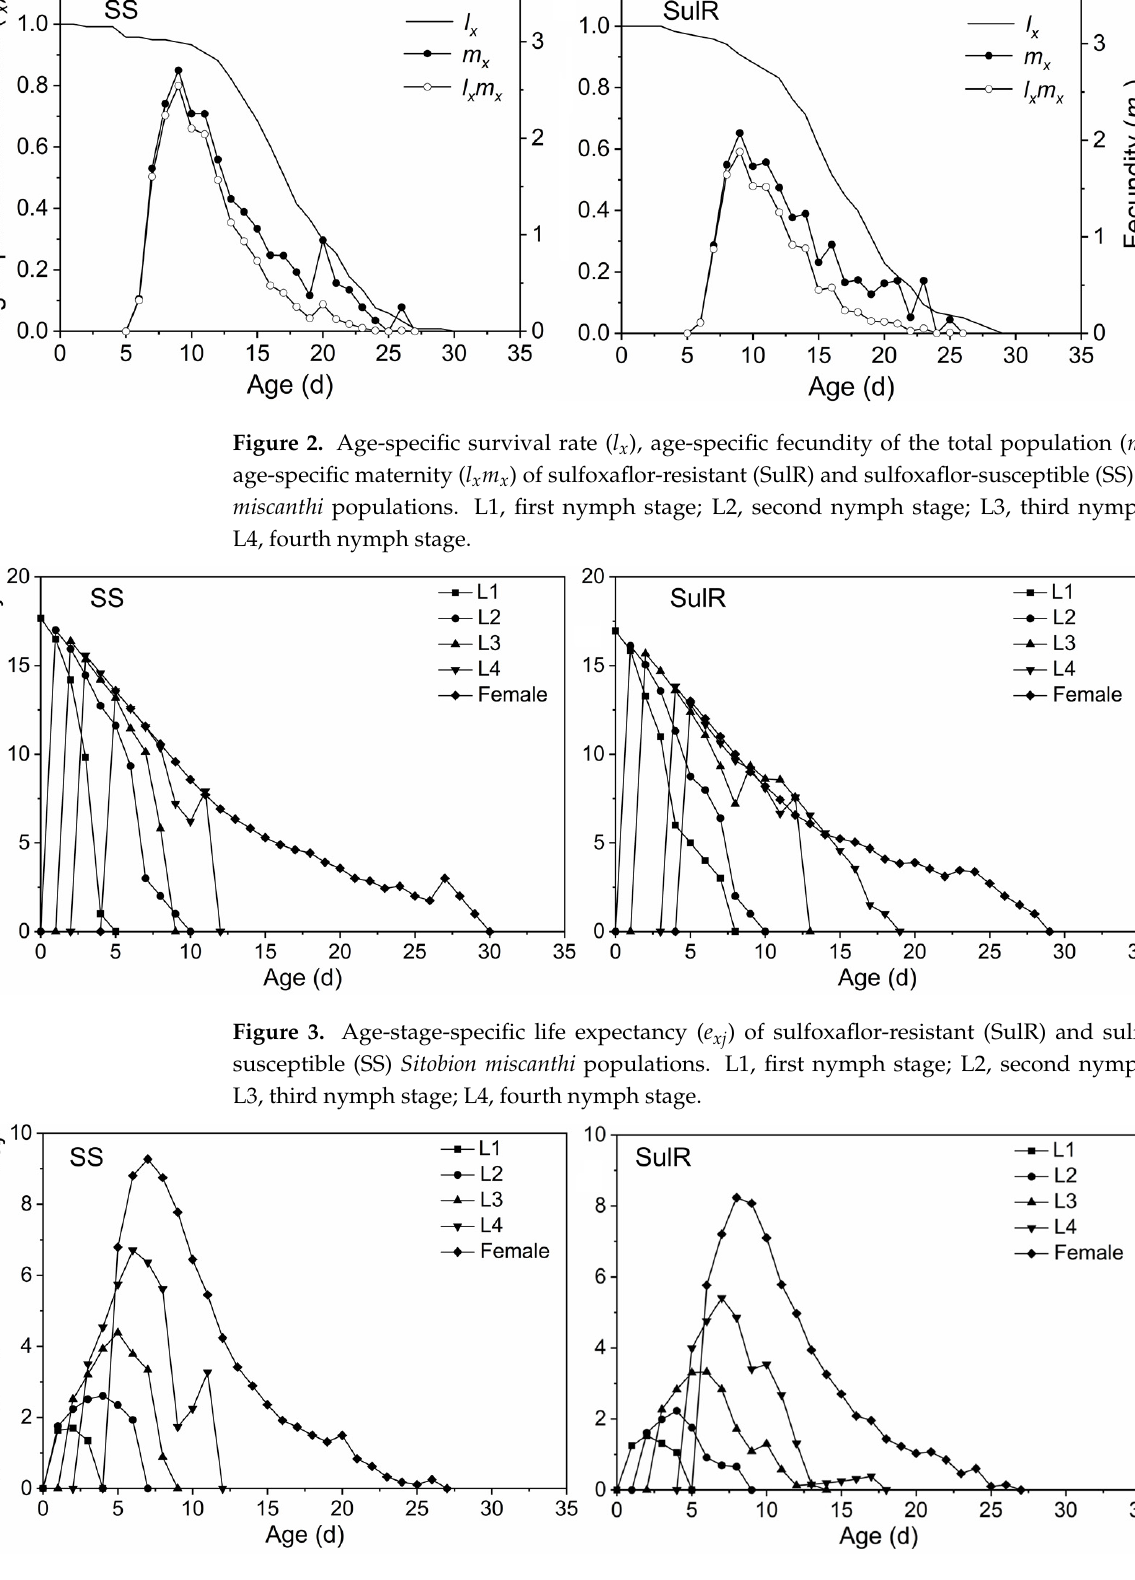
Figure 4. Age-stage-specific reproductive rate ( v xj ) of sulfoxaflor-resistant (SulR) and sulfoxaflor- susceptible (SS) Sitobion miscanthi populations. L1, first nymph stage; L2, second nymph stage; L3, third nymph stage; L4, fourth nymph stage.